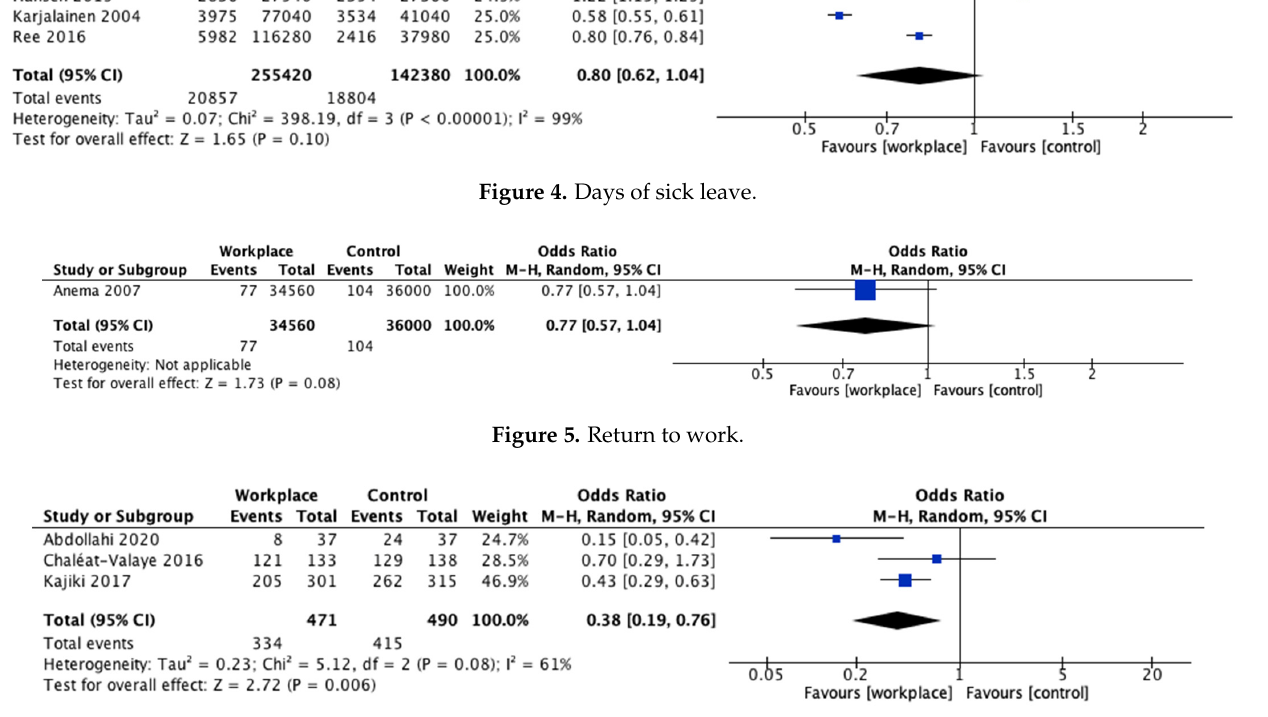
Figure 6. Low back pain recurrence.